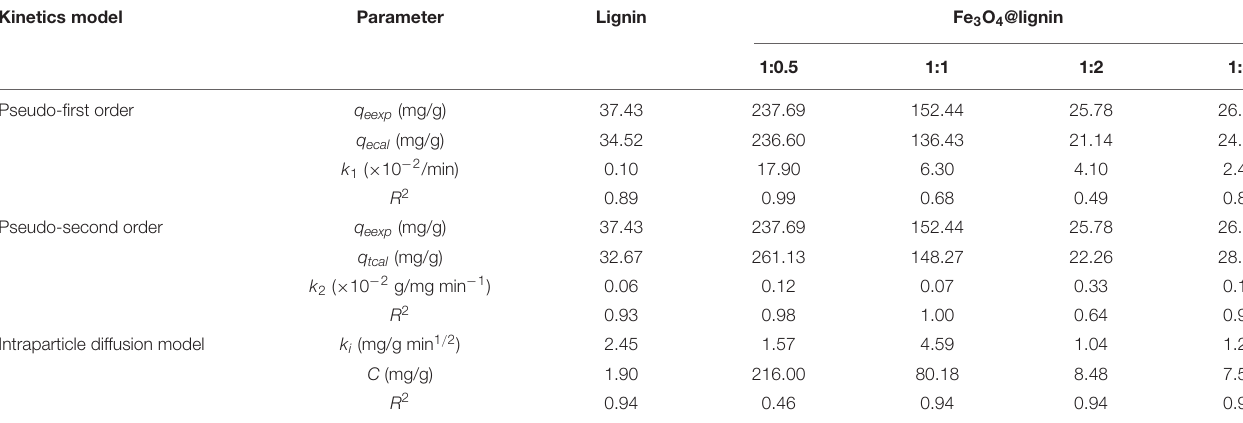
TABLE 2 | Kinetic parameters for the adsorption of Congo red dye on lignin and magnetic lignin composites. Kinetics